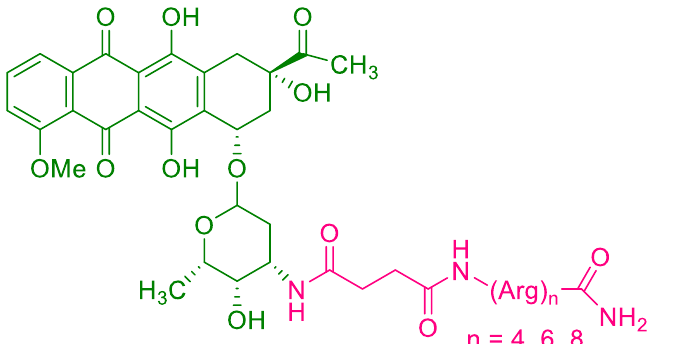
Figure 22. Oligoarginine-daunomycin